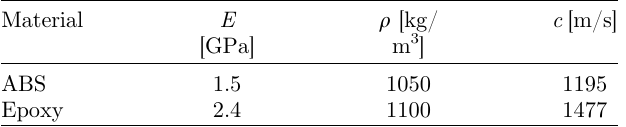
Table 1. Young ’ s modulus ( E ), mass density ( q ), and sound speed ( c ) of the constituent materials of the